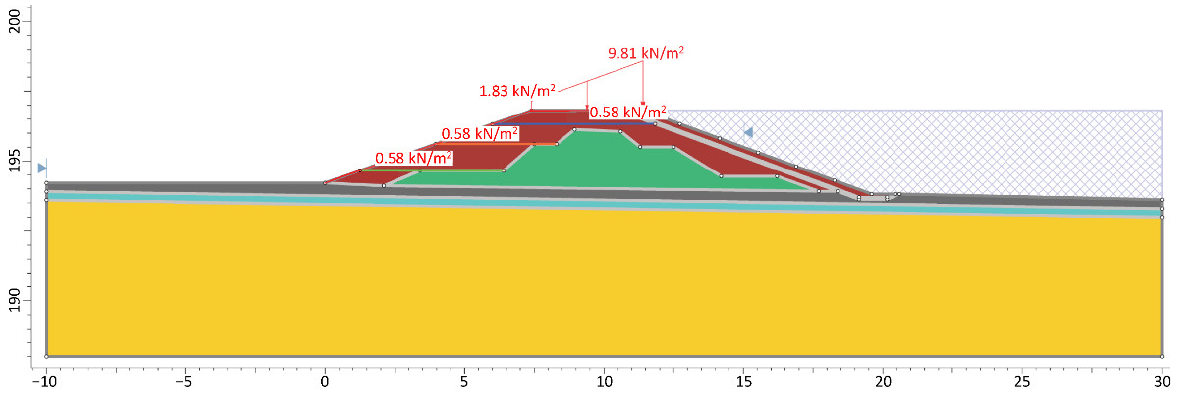
Figure 4. Numerical model for analyses of case study levee.